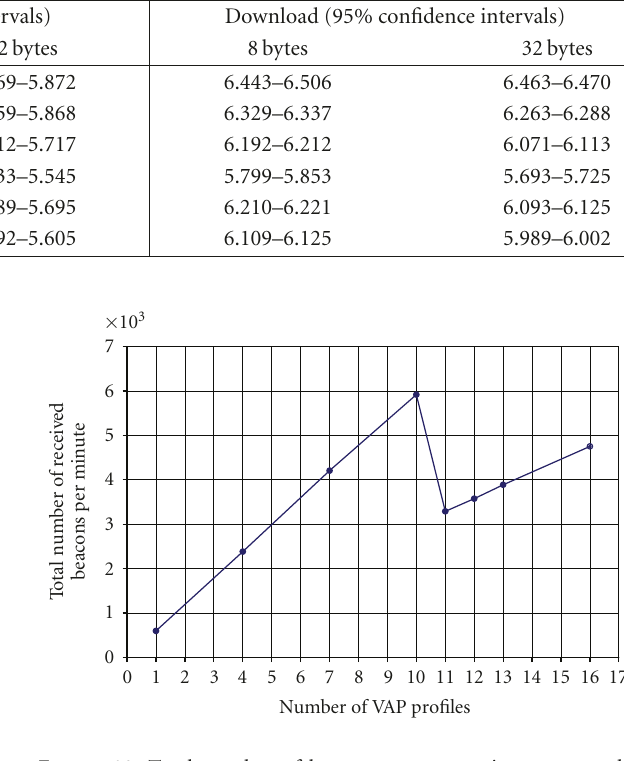
Figure 20: Total number of beacons sent per minute versus the number of active profiles.